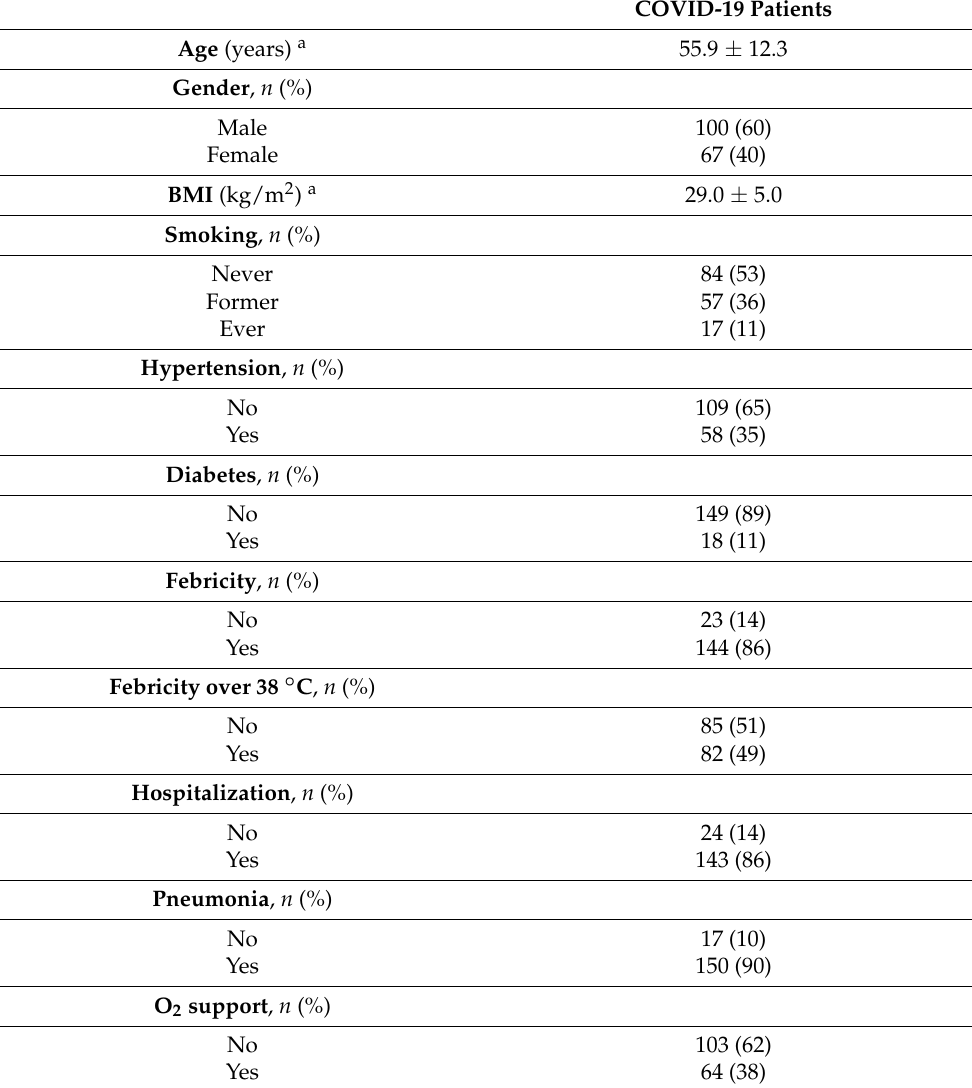
Table 1. Clinical characteristics of COVID-19